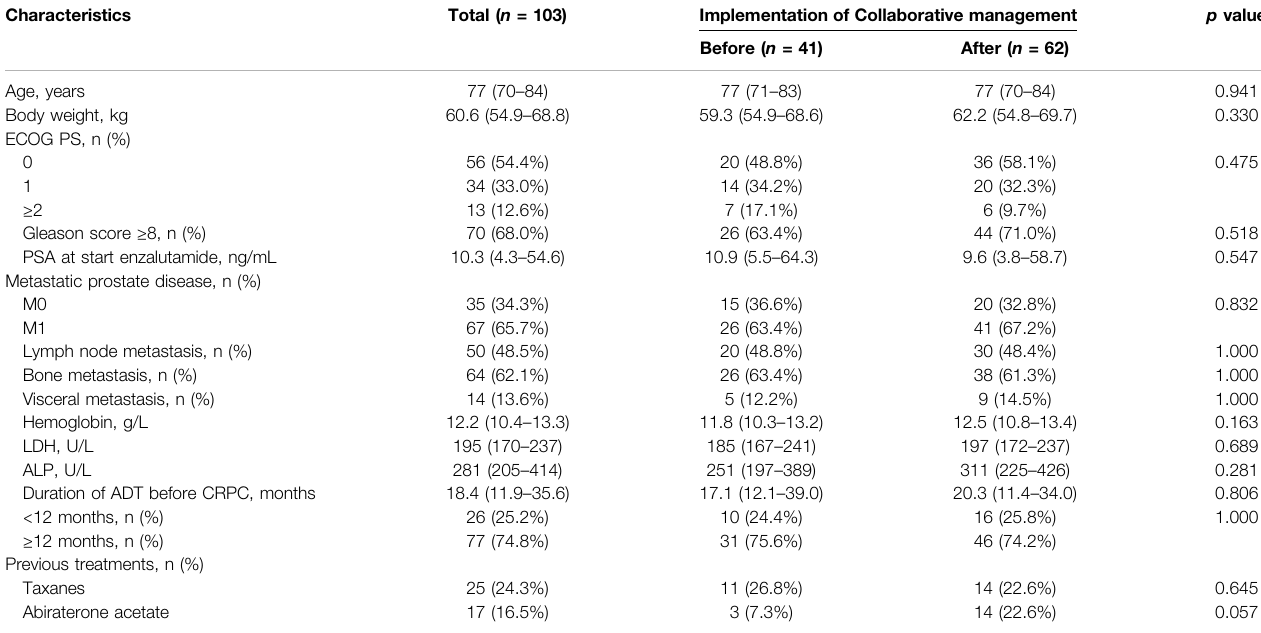
TABLE 1 | Baseline patient